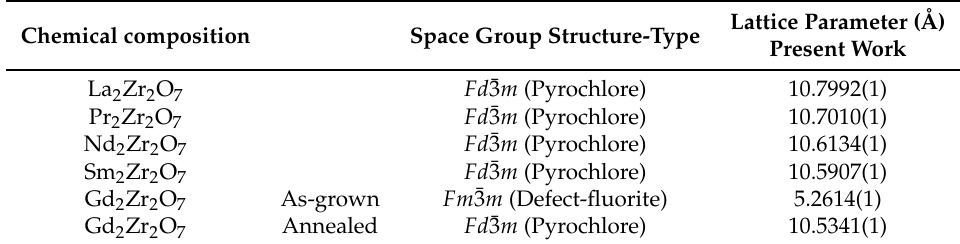
Table 5. Lattice parameters for A 2 Zr 2 O 7 (with A “ La Ñ Gd), refined from the room temperature powder X-ray diffraction